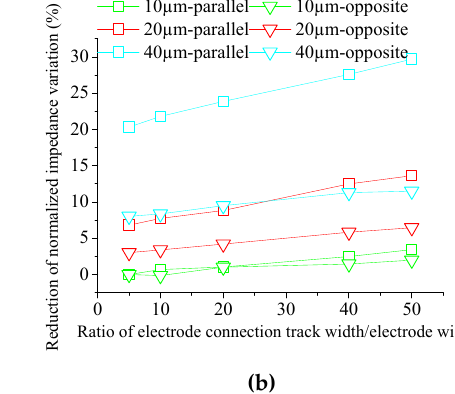
Figure 7. ( a ) Graph of the ratio of cell diameter/electrode width versus normalized impedance variation for three electrode sizes with the same connection track dimensions and ( b ) graph of the ratio of electrode connection track width/electrode width versus the alteration of normalized impedance variation for three different lengths of electrode connection tracks.